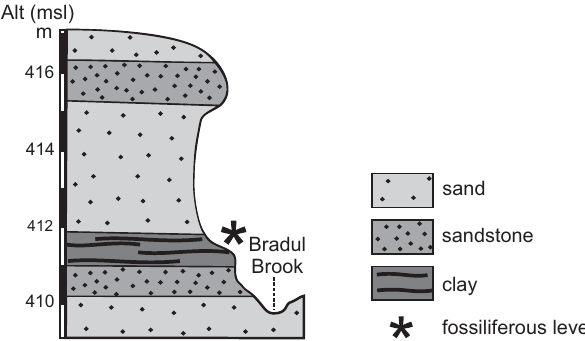
Fig. 3. Section and stratigraphy of the outcrop with the algal level (asterisk).